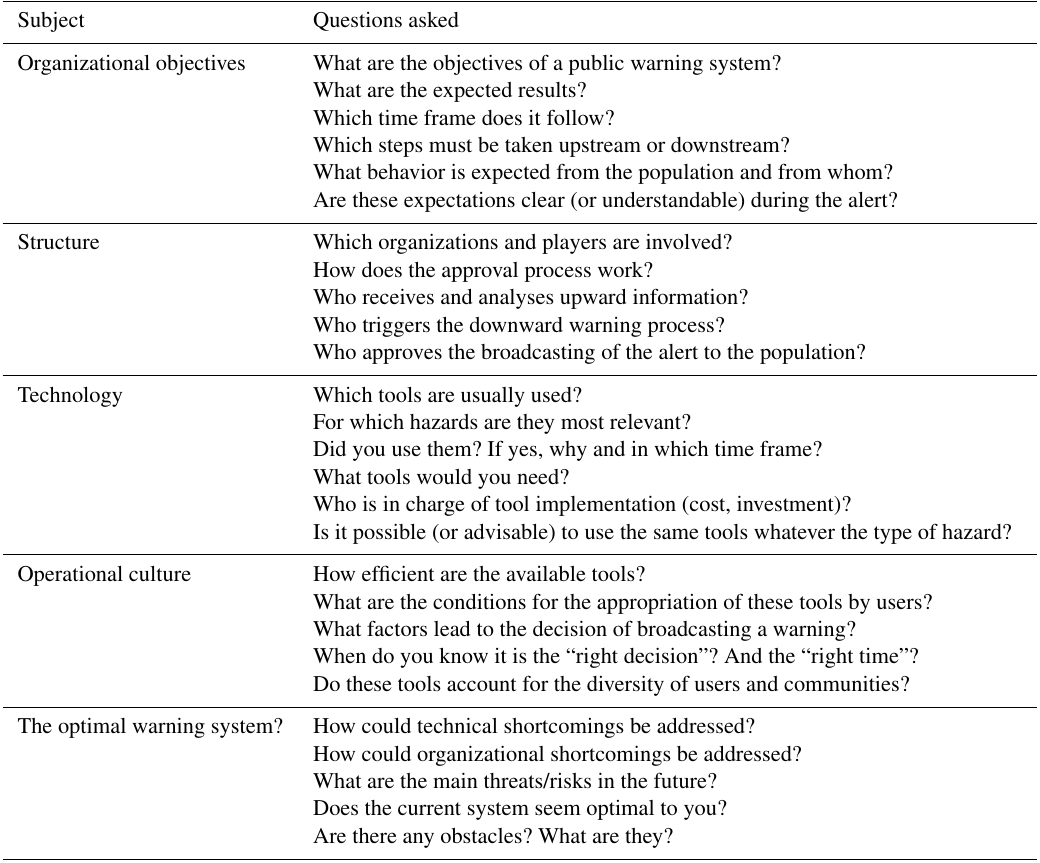
Table A1. Questions included in the questionnaire done by authorities in charge of activating the sirens in 11 cities of